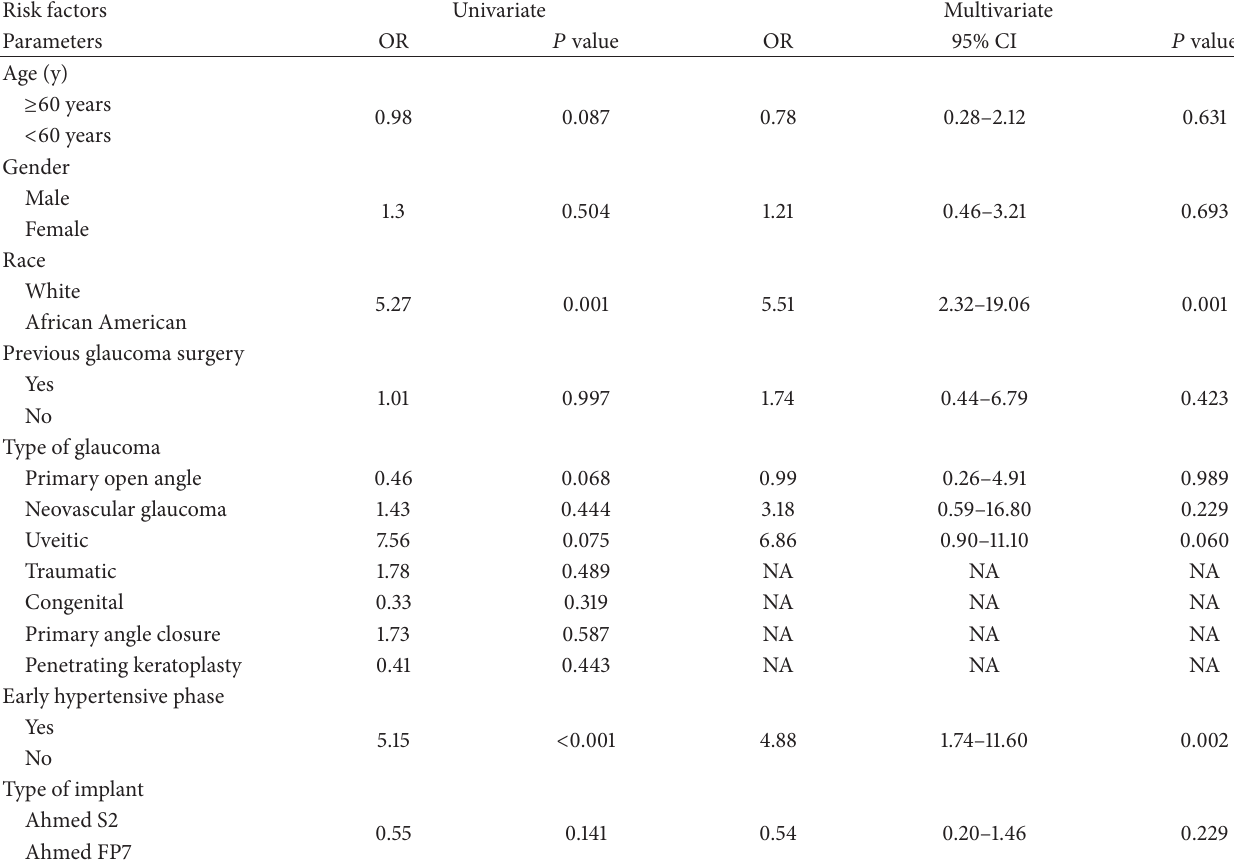
Table 5: Univariate and multivariate analysis to evaluate risk factors following Ahmed Glaucoma Valve